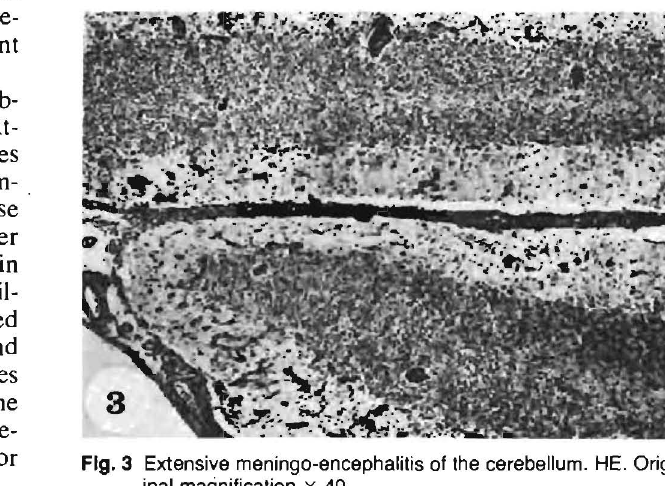
Fig. 3 Extensive meningo-encephalitis of the cerebellum. HE. Orig inalmagnification x